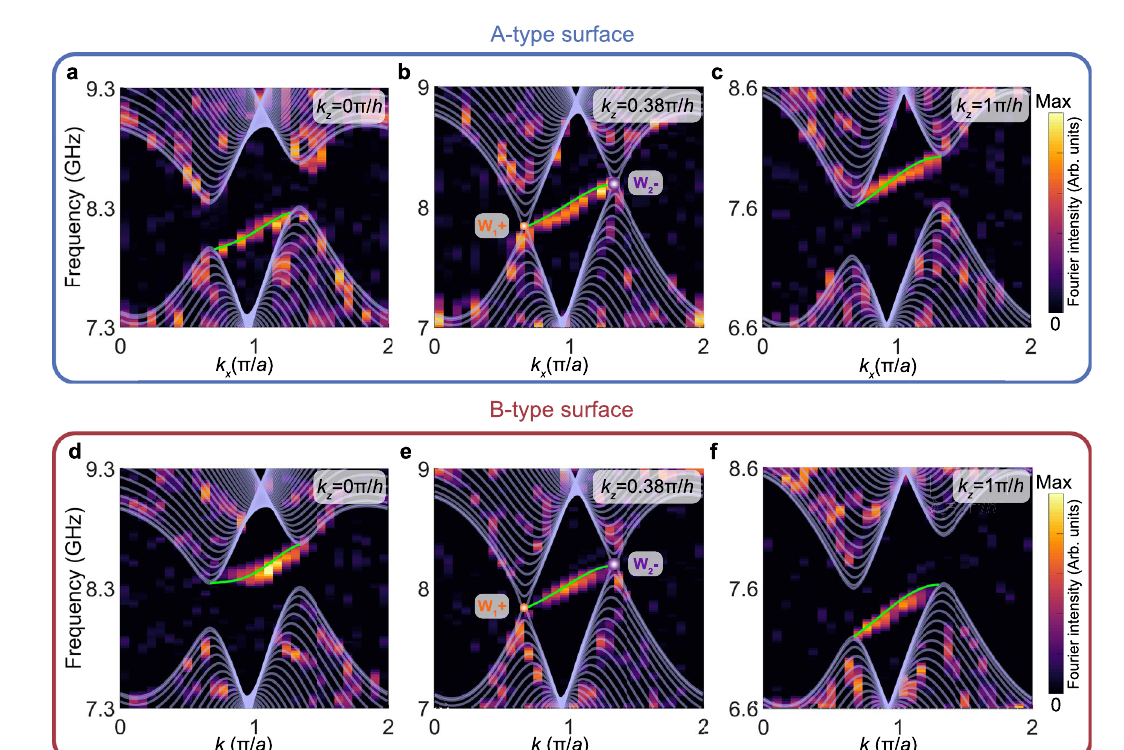
A-type surface at b 7.85GHz, c 8.02GHz, and d 8.22GHz. The white (green) lines representthe simulated bulk(surface)dispersions. Theorange and purplespheres represent the projections of the frequency-shifted WPs with opposite topological charges. f – h Measured iso-frequencycontoursofthe topological surface stateson the B-type surface at f 7.85GHz, g 8.02GHz, and h 8.22GHz.